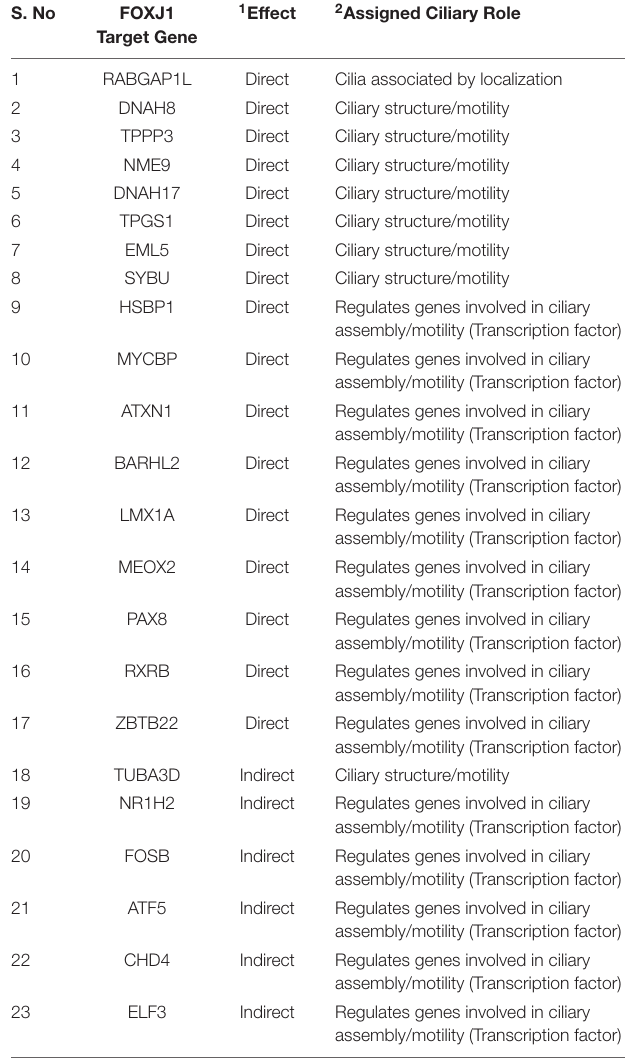
TABLE 1 | Novel predicted functions of FOXJ1 regulated genes based on gene ontology